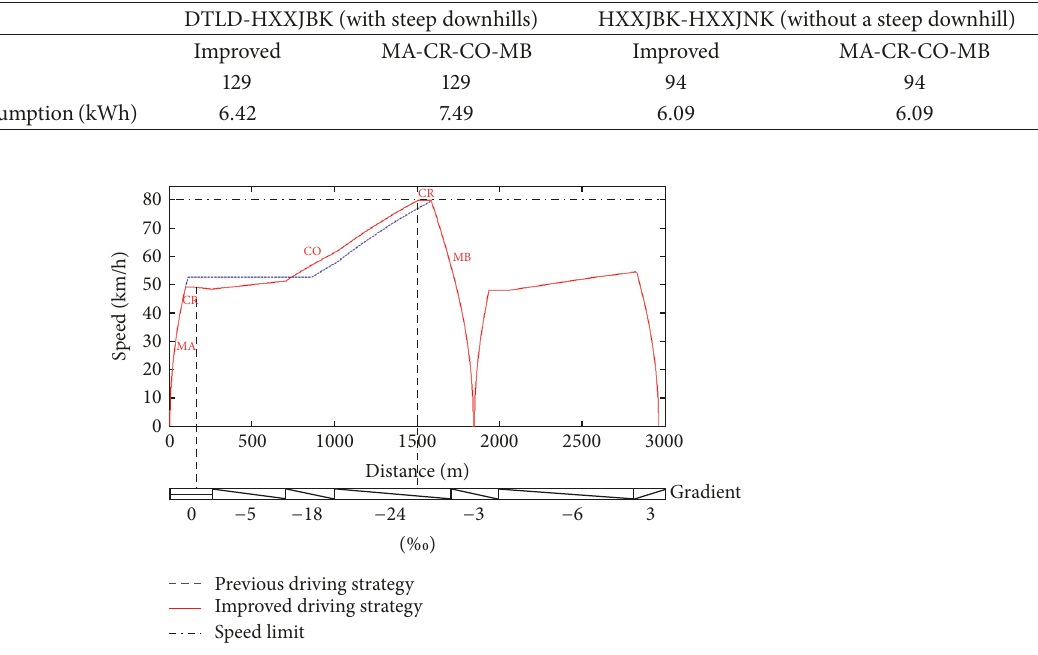
Figure 13: The comparison between two driving strategies.